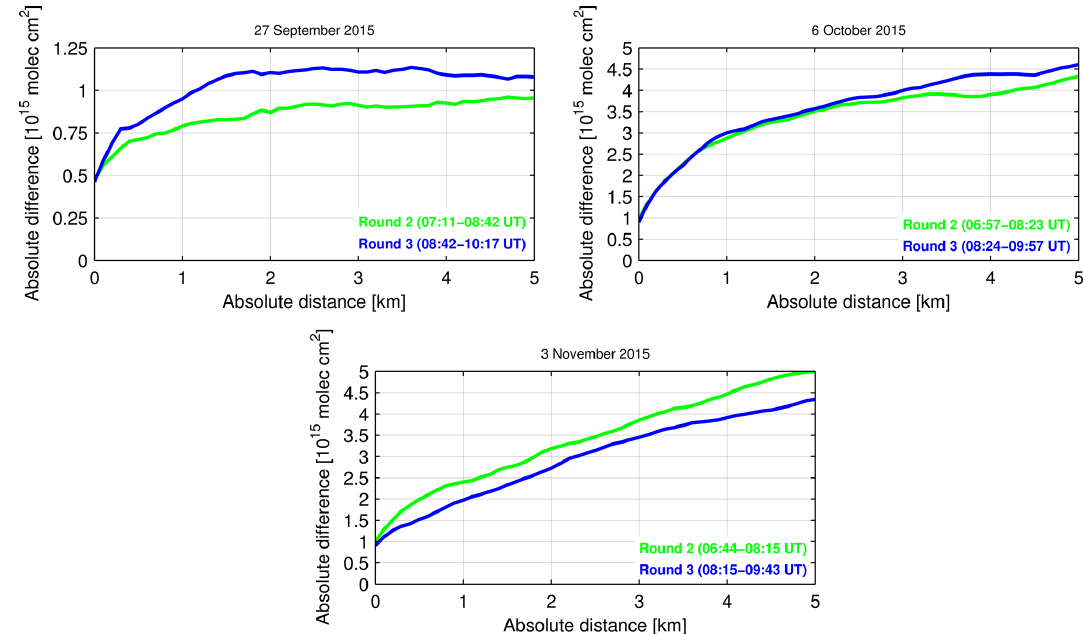
Figure 9. Mean absolute difference in NO 2 DSCDs as a function of the absolute distance (see Sect. 3.2.1) for car DOAS zenith-sky mea- surements performed on three selected days with different wind conditions and NO 2 levels.